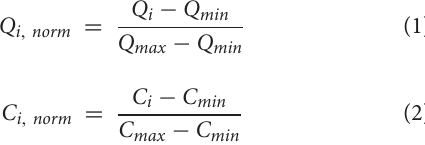
Frontiers in Marine Science |